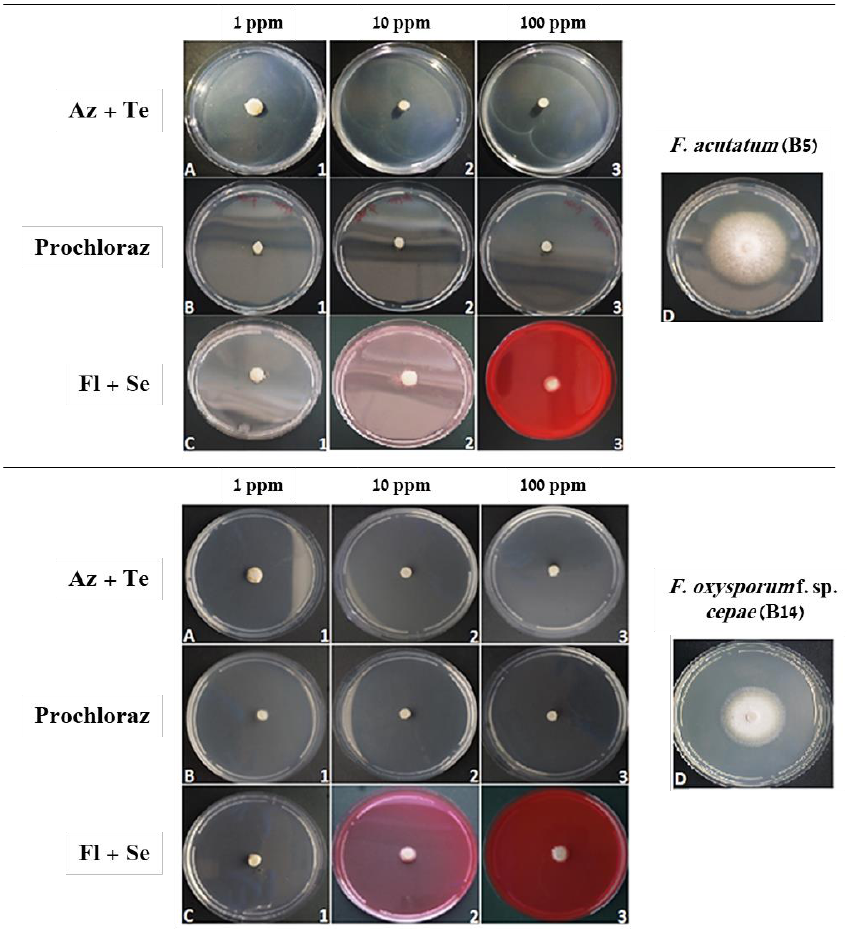
Figure 2. Effect of selected fungicides on the development of Fusarium oxysporum f. sp. cepae (iso- late B14) in culture media. The experiment was conducted as described in Figure 1. The columns represent an average diameter of six replications, error lines represent a standard error. Different letters above the columns represent a significant difference ( p < 0.05) in the ANOVA test.